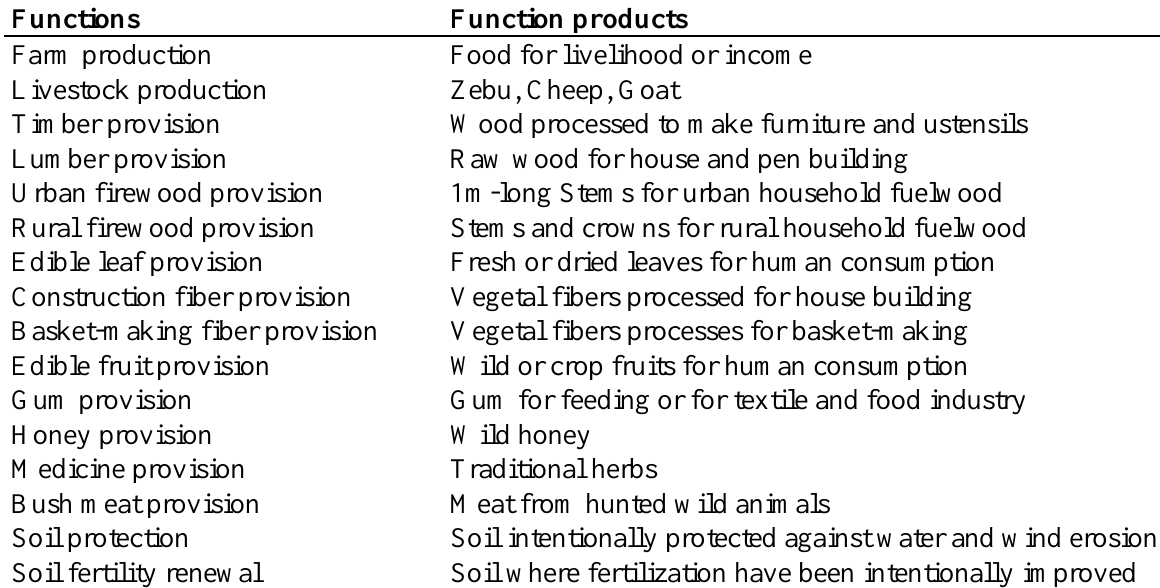
Table A1.1: List of SES functions identified in Ñinpelima and their respective products